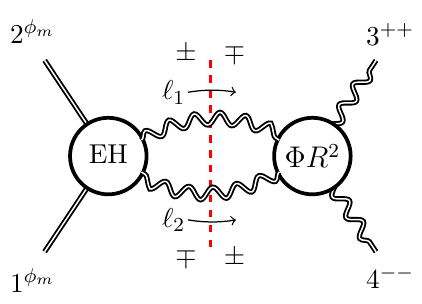
Figure 4 . The cut diagram contributing to the leading (Φ R 2 ) 2 correction to gravitational scattering of a graviton (double wavy lines) off a massive scalar (double